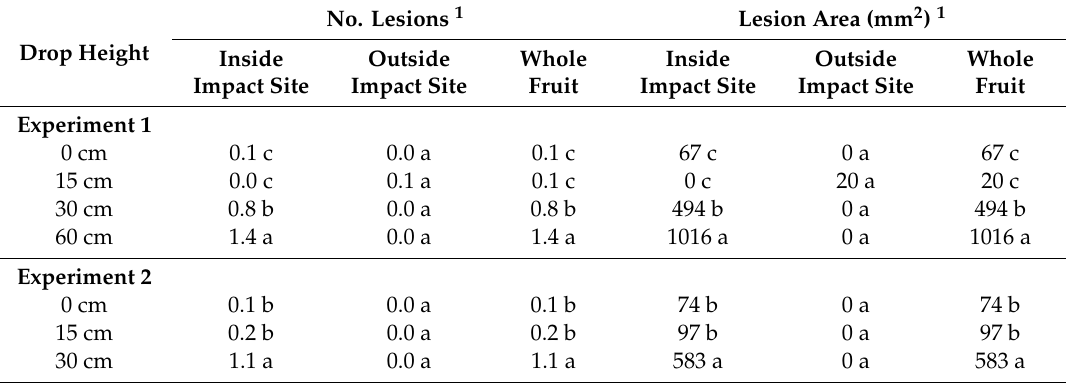
Table 4. Lesion number and lesion area inside the impact site, outside the impact site and for the whole fruit in 2016 season ‘Hass’ avocado fruit dropped from varying heights on the day of harvest in Experiments 1 and 2, and assessed at soft-ripe stage.